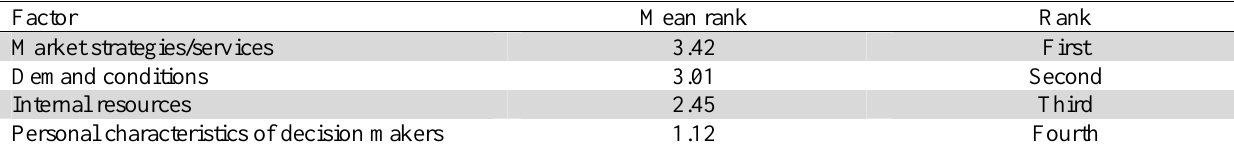
The summary of ranking factors based on Freedman test for Keyson Factor